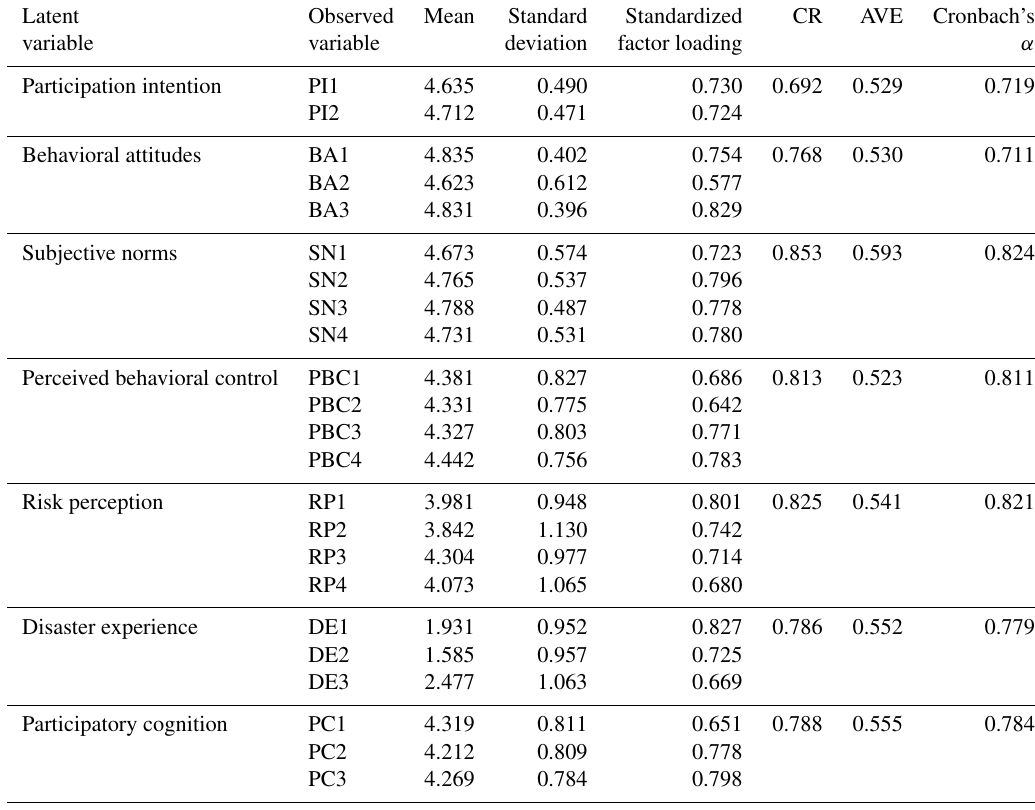
Table 3. Results of the reliability and validity tests.